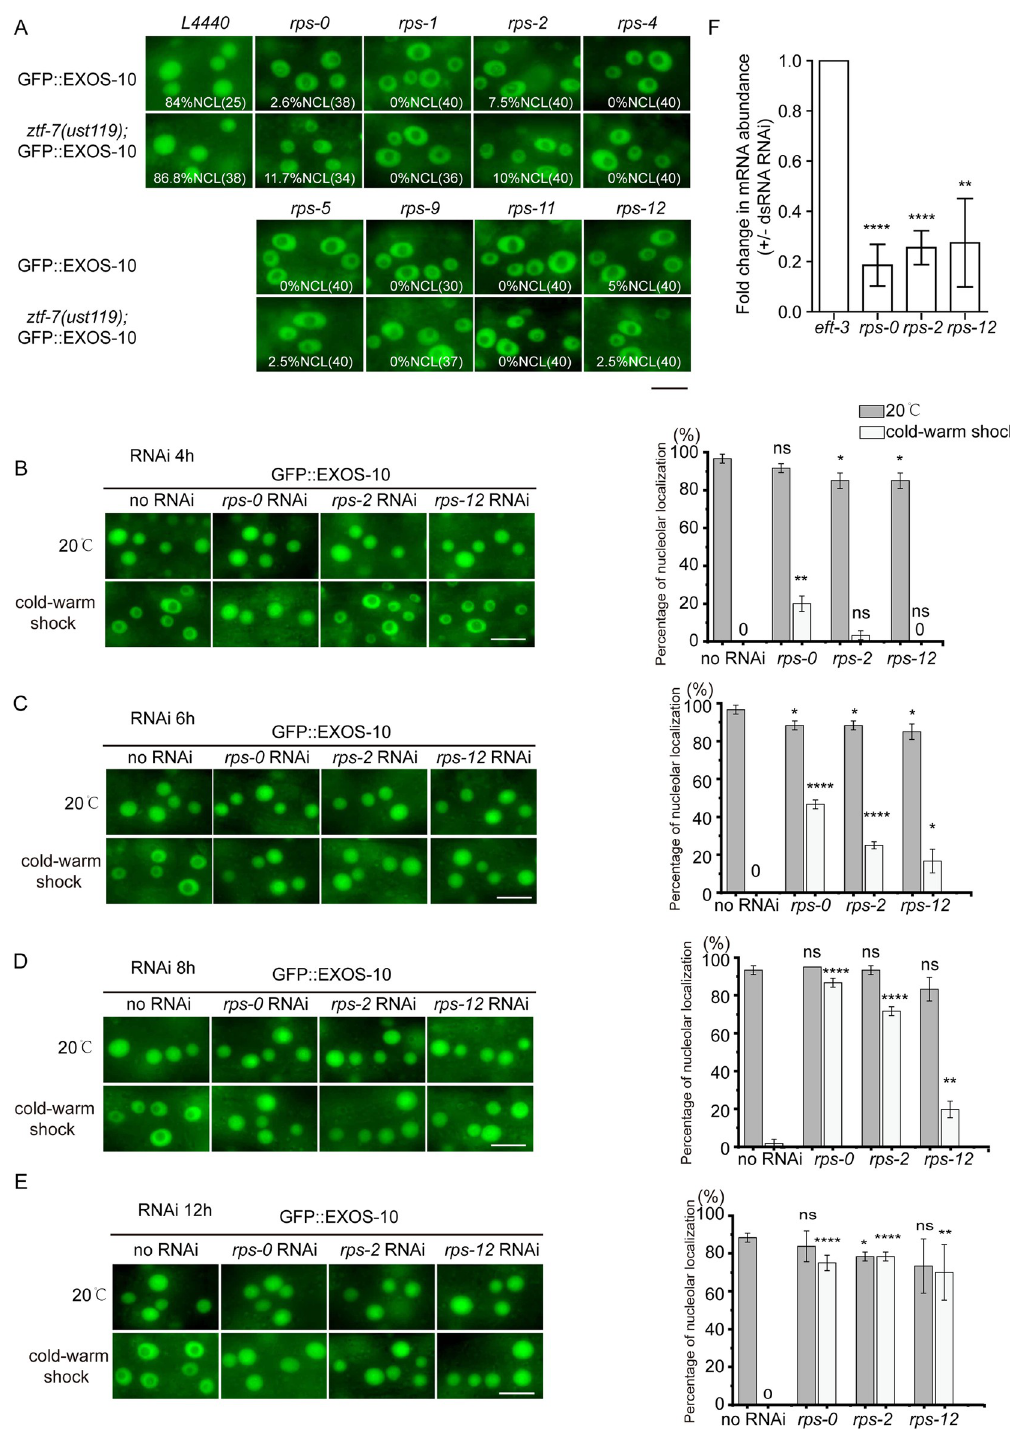
Fig 7. RPS proteins are required for cold-warm shock-induced RNA exosome translocation. (A) Images of epidermal cells of animals expressing GFP::EXOS-10 after treatment with RNAi targeting the indicated genes. Bleached embryos carrying EXOS-10 transgenes were grown on RNAi plates for 48 h before being photographed. The percentage of animals with nucleolar-localized GFP::EXOS-10 is indicated (% NCL). The number of scored animals is indicated in parentheses. Scale bars, 10 μ m. Animals were cultured at 20˚C. (B-E) (Left) Images of epidermal cells of animals expressing GFP::EXOS-10 after treatment with RNAi targeting the indicated genes for 4, 6, 8 or 12 hours. Animals were cold-warm shocked at 4˚C for 3